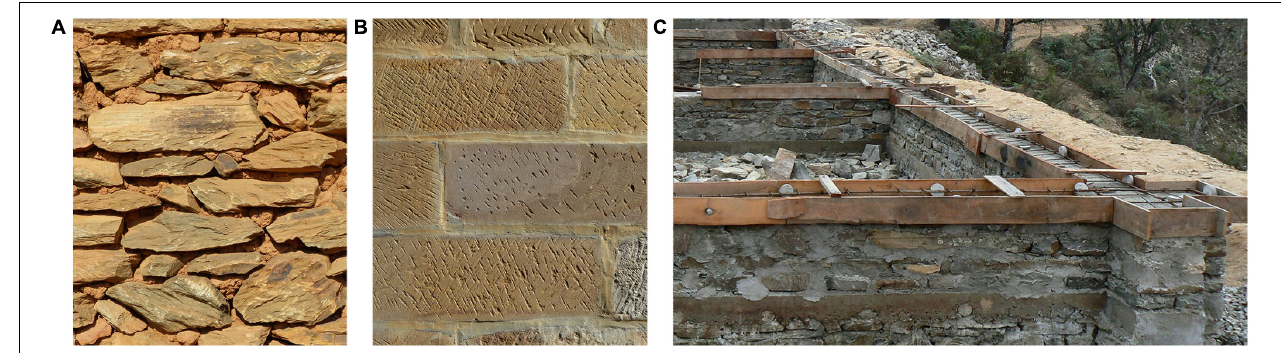
FIGURE 1 | (A) Unreinforced random rubble stone masonry with mud mortar. (B) Unreinforced Ashlar stone masonry with lime-sand mortar. (C) Nominally reinforced random rubble stone masonry with cement mortar and brought to courses (all by courtesy of Smart Shelter